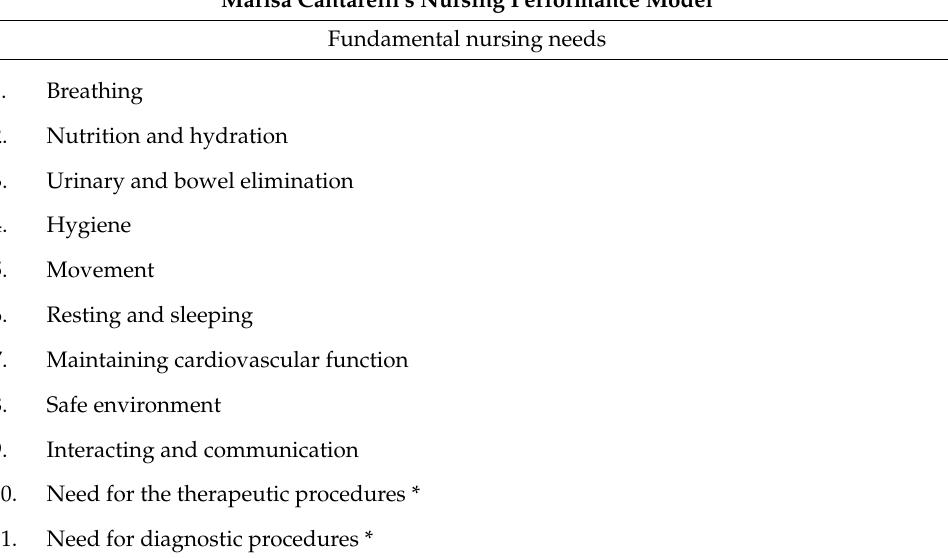
Table 2. The fundamental nursing needs based on Marisa Cantarelli’s Nursing Performance Model. Marisa Cantarelli’s Nursing Performance